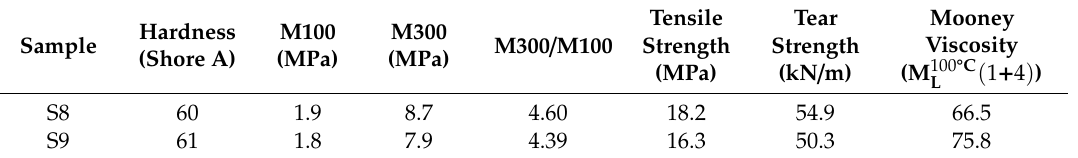
Table 5. Test results of mechanical properties and machining